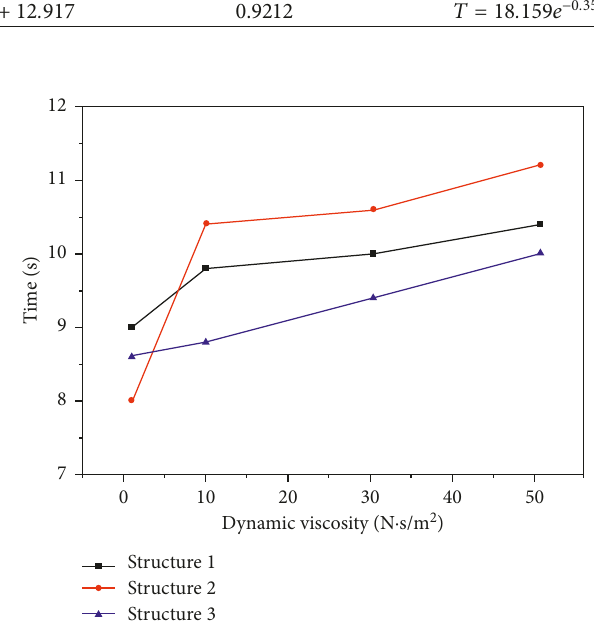
Figure 6: Relationship between the seepage time and the dynamic viscosity in each filling